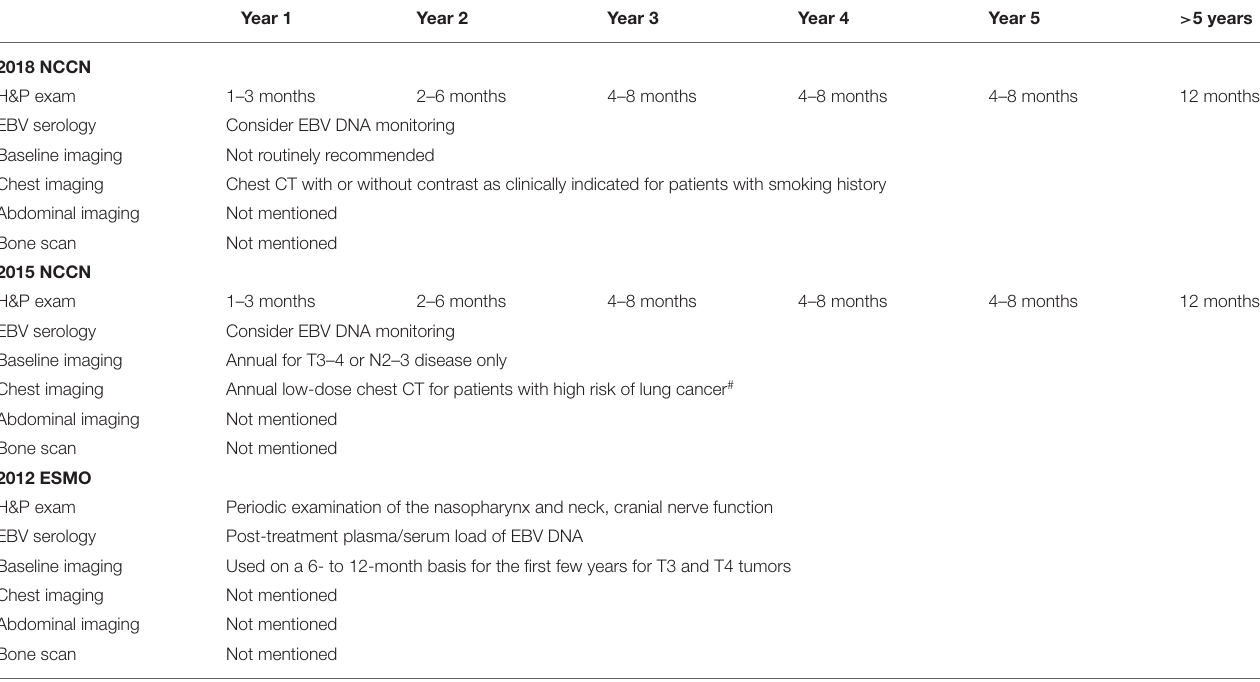
TABLE 1 | NCCN, ESMO, and AHNS oncologic surveillance schedules for